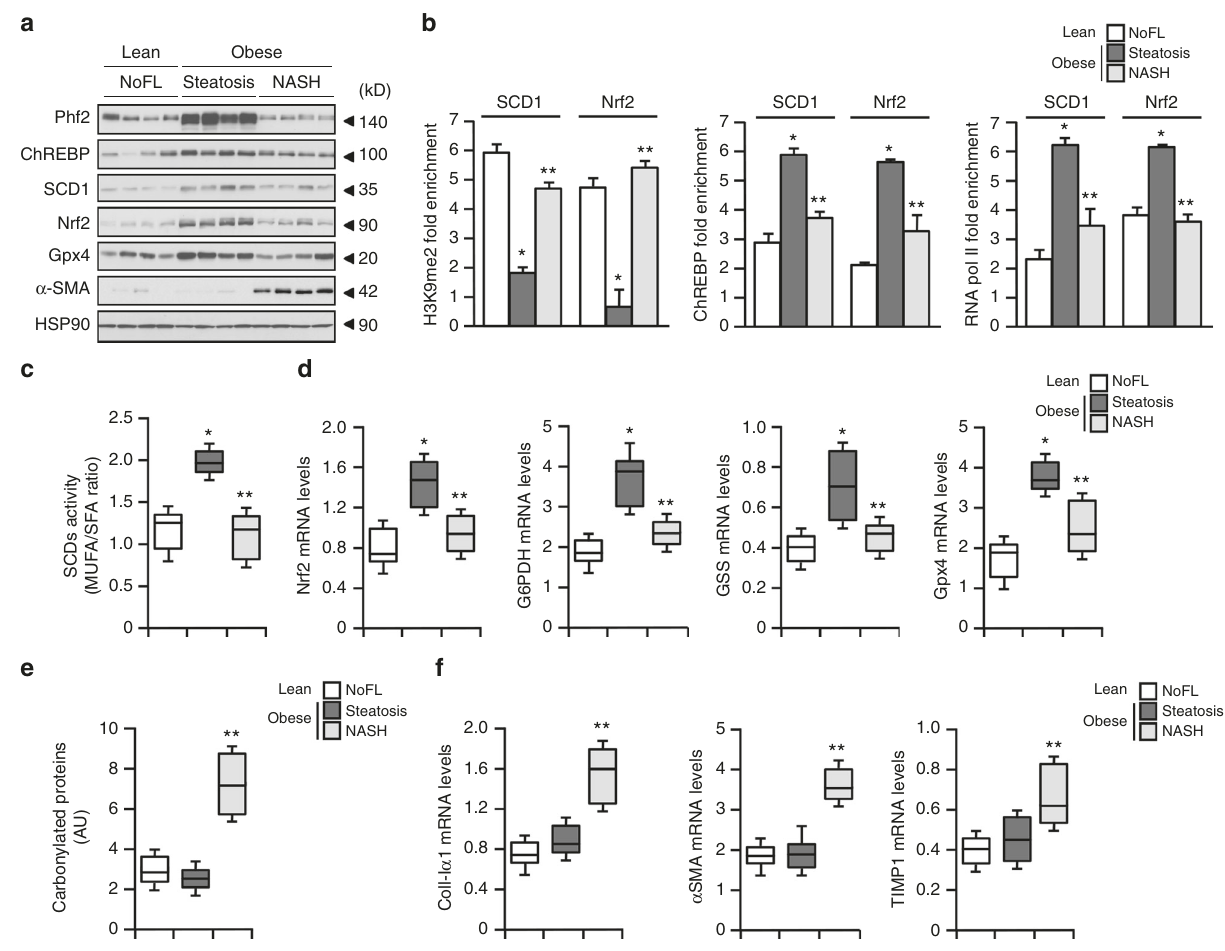
Fig. 9 Phf2 expression is increased in the liver of obese patients with benign hepatic steatosis and positively correlates with insulin sensitivity. Human liver biopsies from lean subjects with no fatty liver (NoFL) or obese patients with simple steatosis or NASH were obtained from the ABOS cohort. a Representative Western blot analysis of Phf2, ChREBP, SCD1, Nrf2, Gpx4, and α -SMA expression ( n = 10 per group). b ChIP experiments for H3K9me2 levels and for the recruitment of ChREBP and the RNA polII at the SCD1 and Nrf2 promoter ( n = 10 per group). c MUFA/SFA ratio re fl ecting SCD1 activity ( n = 10 per group). d Expression of Nrf2 and Nrf2-regulated genes ( n = 10 per group). e Levels of carbonylated proteins ( n = 10 per group). f Expression of coll-Ia1, α -SMA, and TIMP-1 ( n = 10 per group). All error bars represent mean ± SEM. Statistical analyses were made using Anova, followed by Bonferonni ’ s test. *Obese with steatosis compared to lean with noFL; P < 0.01. **Obese with steatosis compared to obese with NASH; P <